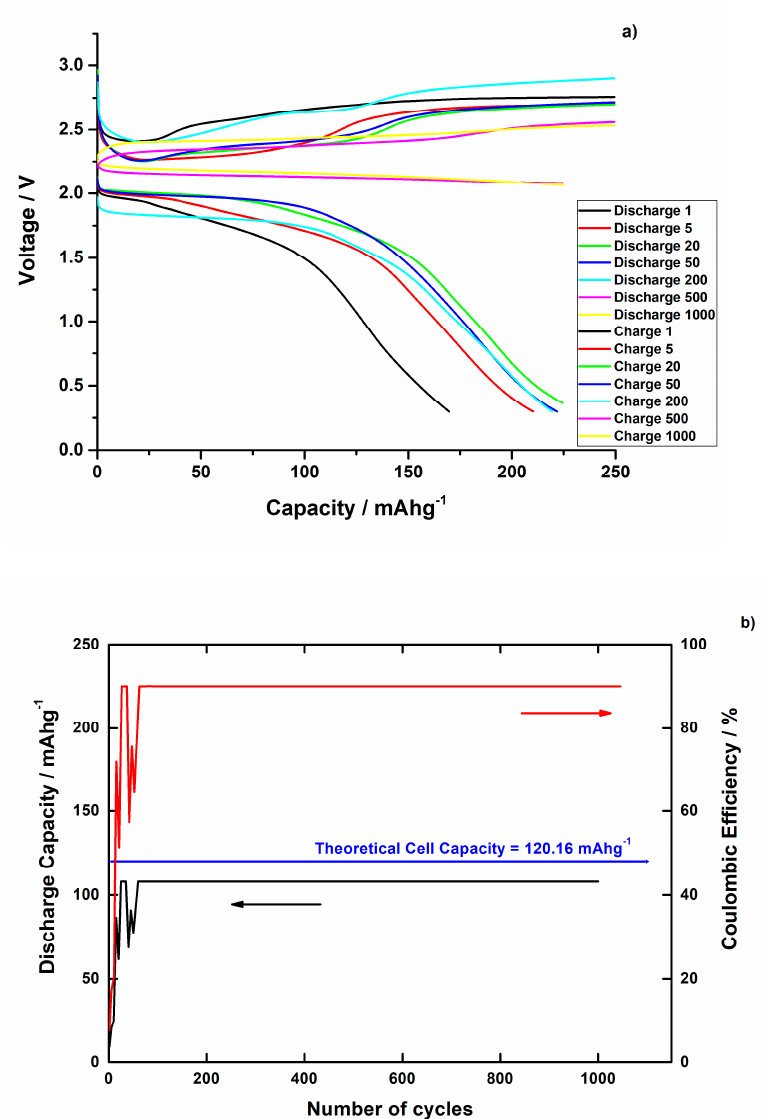
Figure 9. Electrochemical performance of nanostructured lead-acid electrodes operating at 40 ± 2 °C and 10 C: ( a ) charging and discharging curves of different cycles, and ( b ) cycling efficiency on discharging and discharge capacity.